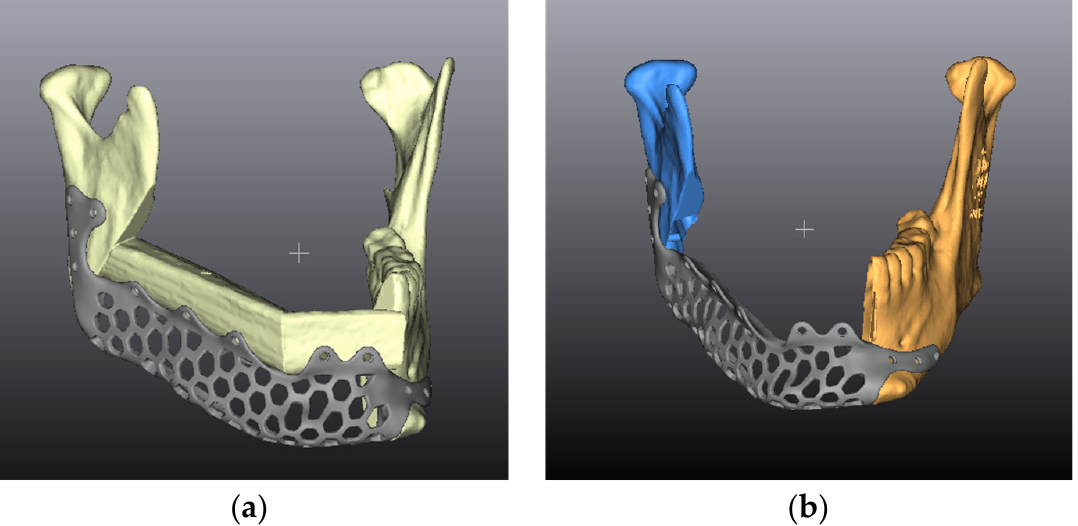
Figure 5. ( a ) Example of a 3D model of reconstructive planning. ( b ) Example of the obtained CMSs. CMSmaj is shown in orange, CMSmin in blue.